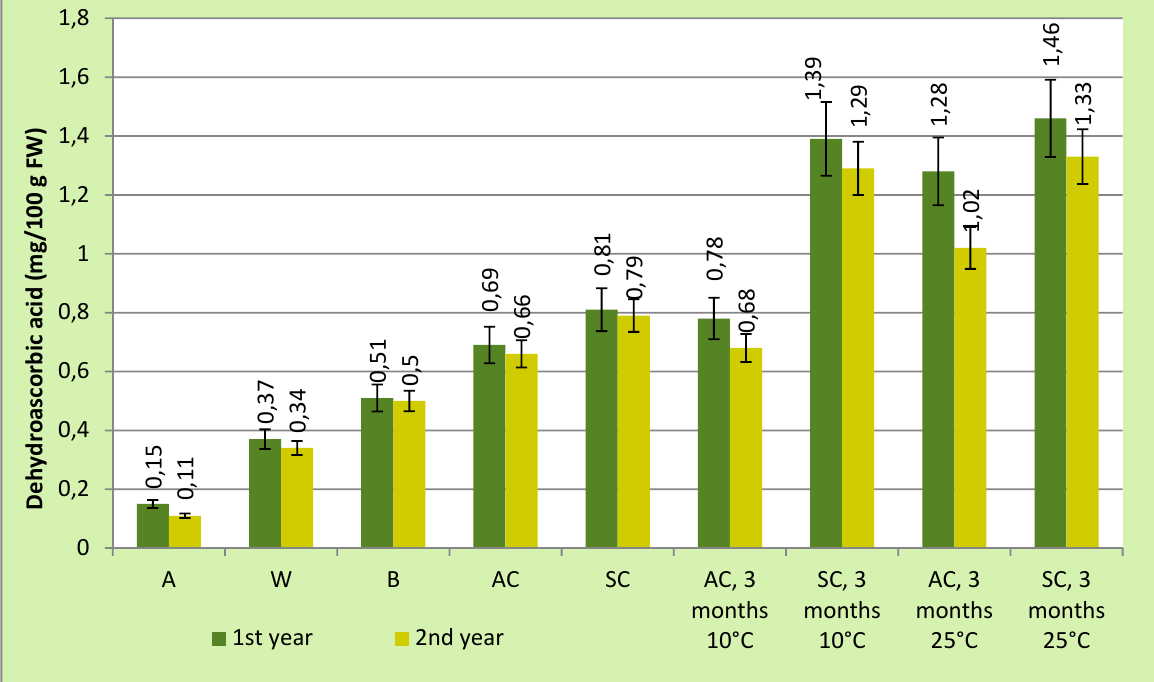
Figure 5. HPLC content of dehydroascorbic acid during the technological flow of apricot compote fabrication and the 3 months preservation at 10 °C and 25 °C: apricot raw material (A), washed fruits (W), after blanching (B), apricots from compote (AC), and syrup from compote (SC), during two different years. Results are means of 3 determinations±standard